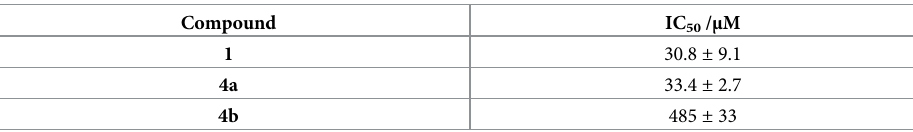
Table 1. RTA inhibitory activity of 1, 4a, and 4b.